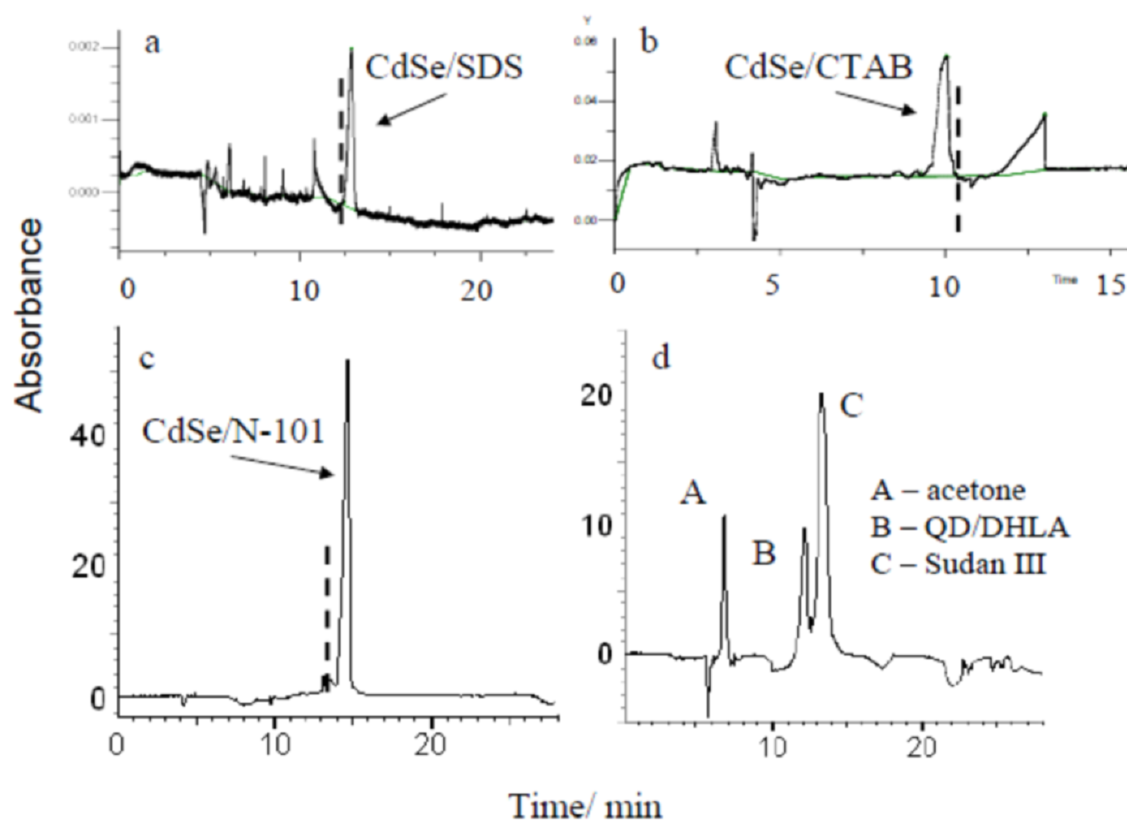
Figure 2. both.MEKC separation of surfactant coated CdSe/TBP/TOPO QDs: (a) anionic, SDS; (b) cationic, CTAB; (c) non-ionic N-101; (d) for comparison the separation of QD/DHLA QDs in this mode is shown. Separation conditions: electrolyte buffer (a, d) 50 mM SDS/10 mM tetraborate buffer; (c) 50 mM SDS/ 1.5 mM tetraborate buffer; (b) 50 mM CTAB/ 10 mM tetraborate buffer. Applied voltage: +20 kV (samples a, b and c), and -20 kV, sample (b). Injections: anode side (samples a, b and c); cathode side (sample b). The dashed lines at (a-c) denote the migration of Sudan III. QDs peaks were confirmed by their characteristic PDA